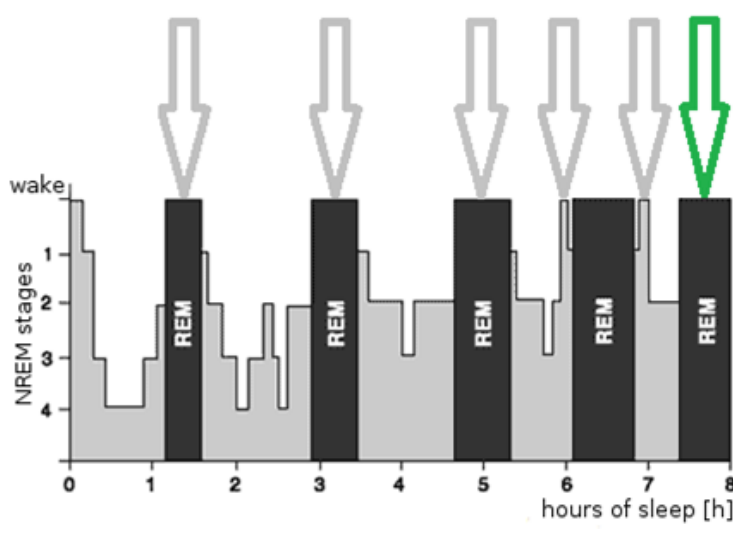
Figure 1. Hypnogram with optimal wake up